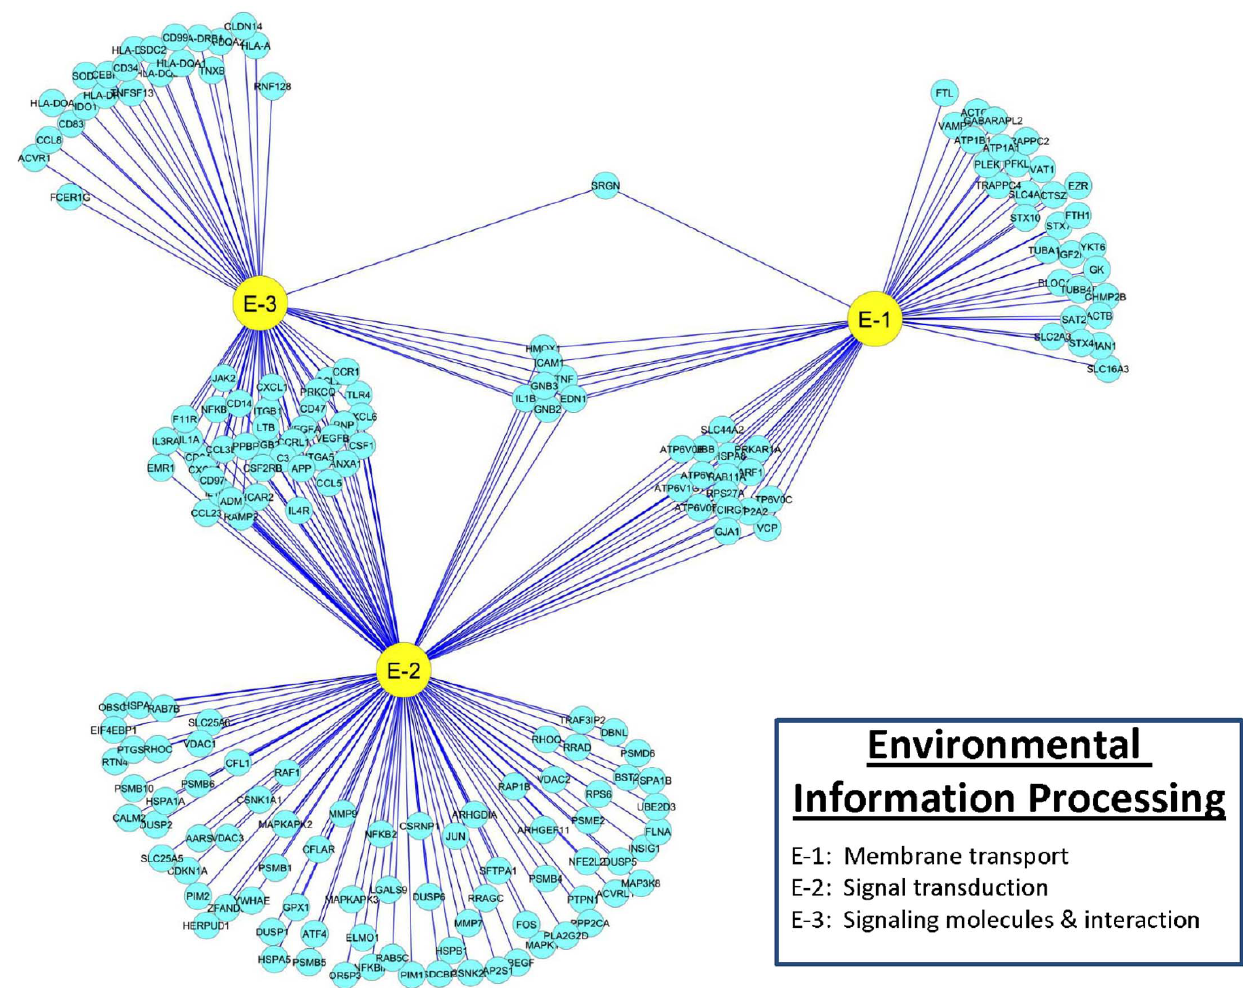
Figure 8. DE gene distributions and interactions among functional categories associated with Environmental Information Processing in PAMs infected with PRRSV.